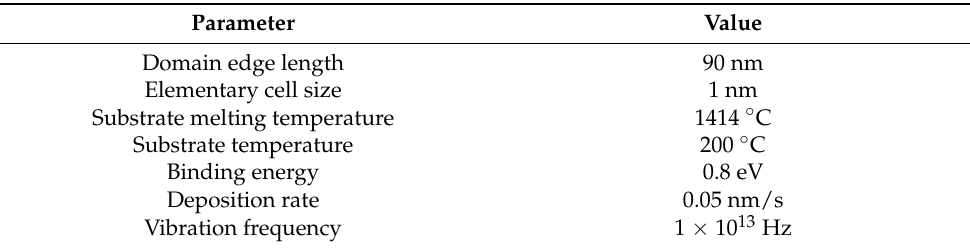
Table 1. Parameters used in the kMC PLD model of the TiN/Si deposition. Table 1 . Parameters used in the kMC PLD model of the TiN/Si deposition.